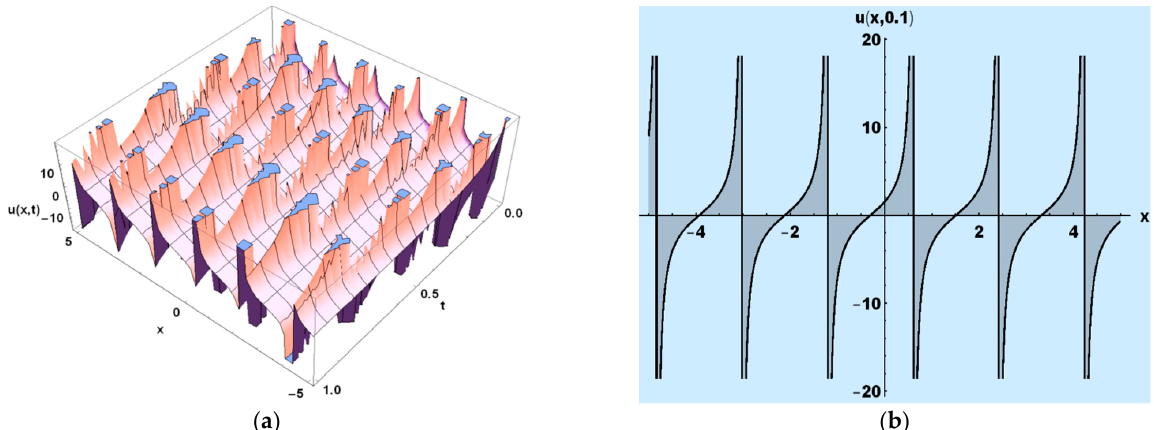
Figure 4. ( a , b ): Graphical analysis of Equation (25) for the values of the parameters a 0 = 2, ,1,1,1,2 FEBA ψ = 1, δ = − 2, L = 1, α = 0.75, − 5 ≤ x ≤ 5, 0 ≤ t ≤ 1 for 3D and t = 0.1 for 2D plots.